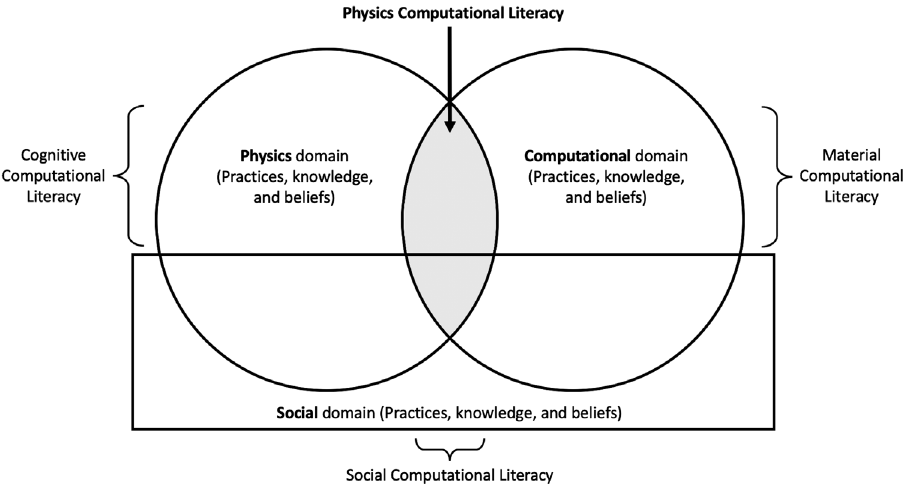
FIG. 1. Theoretical positioning of physics computational literacy relative to physics, computational, and social